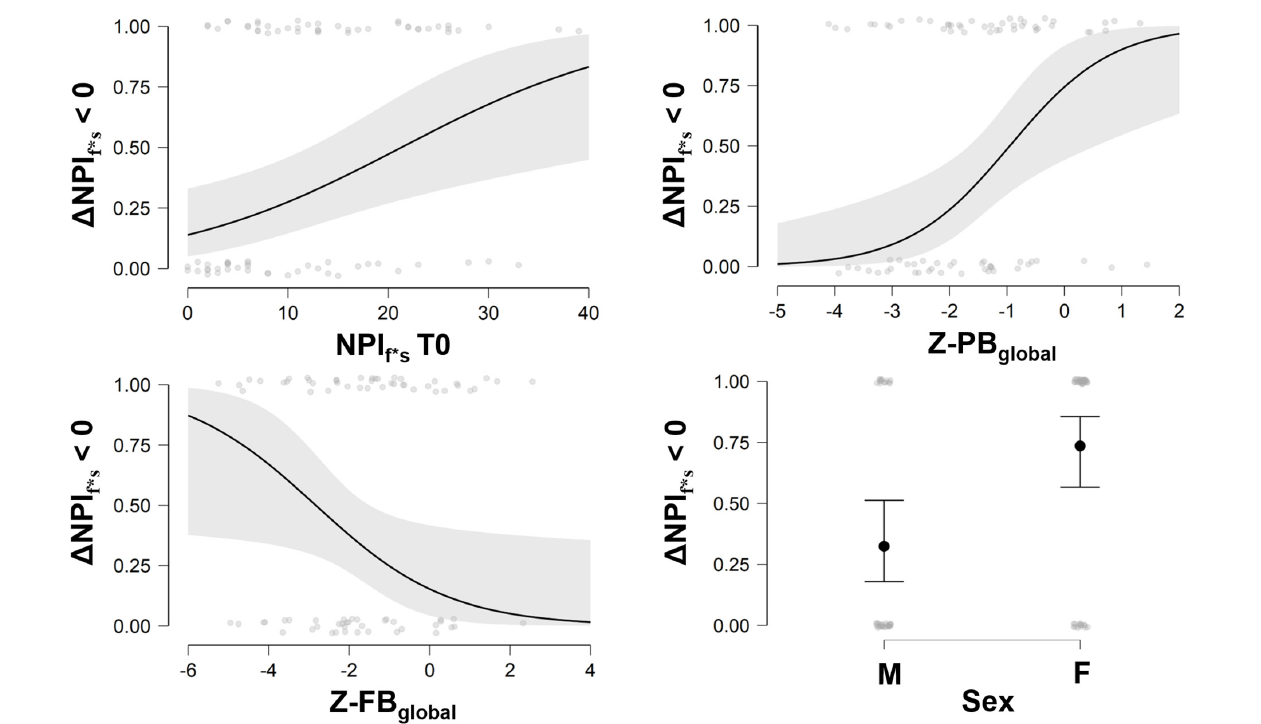
FIGURE 2 | Probability to reduce behavioral symptoms at different scores of NPI f ∗ s at baseline, and Z-PB global , Z-FB global , and sex. NPI, Neuropsychiatric Inventory; (cid:49) NPI f ∗ s > 0, Delta change score (T1–T0) of Neuropsychiatric Inventory frequencies and severity of symptoms; Z-PB global , Z -values of Posterior Brain index; Z-FB global , Z -values of Frontal Brain index; M, males, F, females. Three ranks values can be considered for interpretation purposes for PB index (Low PB: Z-score ranges − 4.10 to − 2.22; Intermediate PB: Z-score ranges − 2.15 to − 0.95; High PB: Z-score ranges − 0.88 to 2.19) and FB index (Low FB: Z-score ranges − 5.25 to − 2.32; Intermediate FB: Z-score ranges − 2.30 to − 0.87; High FB: Z-score ranges − 0.81 to